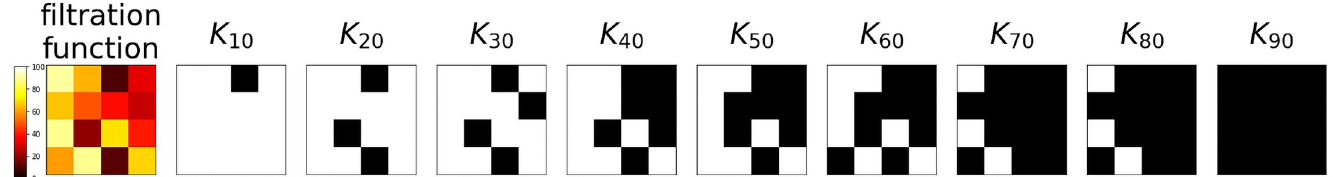
Fig 2. Filtration on a cubical complex. The first image represents the values [0, 100] of the filtration function ϕ . The next nine figures show the cubical complexes K 10 � K 20 � K 30 � ��� � K 90 , where K r corresponds to the union of all cubes, i.e., pixels ( u , v ) with the filtration value ϕ ( u , v ) � r . There is only one 1-dimensional cycle, i.e., hole (one-pixel hole in the third row and third column), which is first seen in K 40 , and then disappears or closes in K 70 .